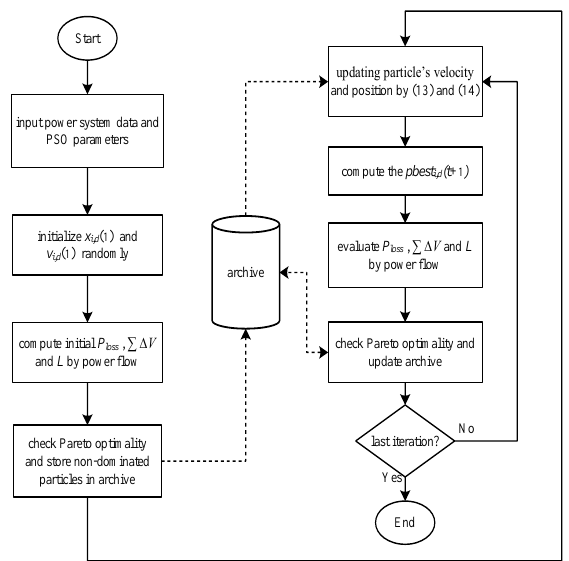
Figure 2. Flowchart for solving MORPD problem using POPSO. Table 2. Control variable settings IEEE 30-bus and